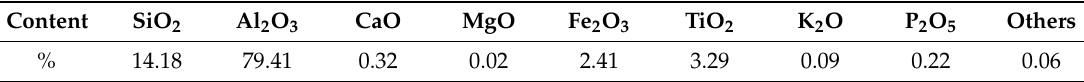
Table 4. Bed material’s chemical properties.